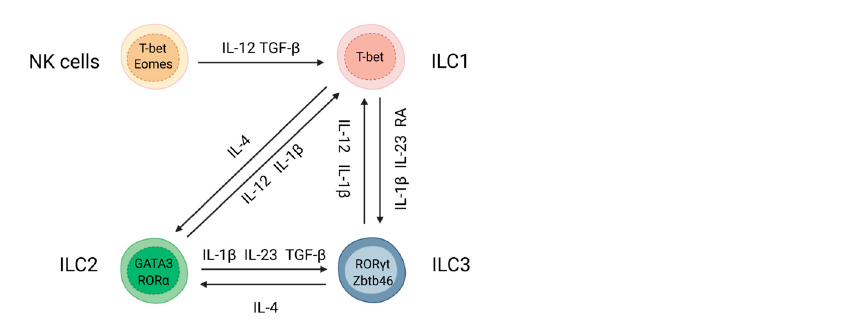
Figure 1. Plasticity among ILC subsets. ILCs plasticity is driven by specific cytokines and the balance between key transcription factors.